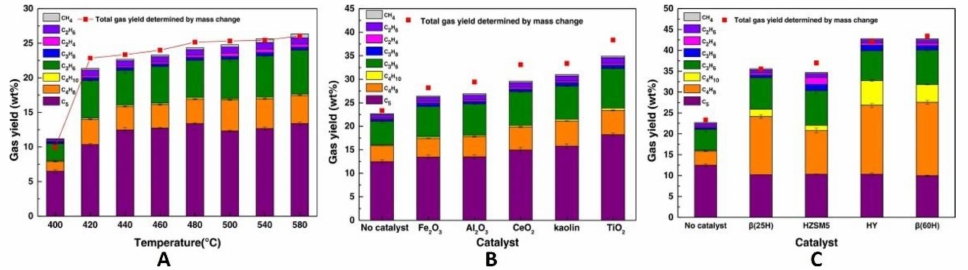
Figure 8. C 1–5 gas product yields from ( A ) thermal pyrolysis of masks at different temperatures; ( B ) oxide-catalytic cracking of pyrolytic volatiles at 440 ◦ C; ( C ) zeolite-catalytic cracking of pyrolytic volatiles at 440 ◦ C. Reproduced with permission from Ref. [39]. Copyright 2022 Elsevier